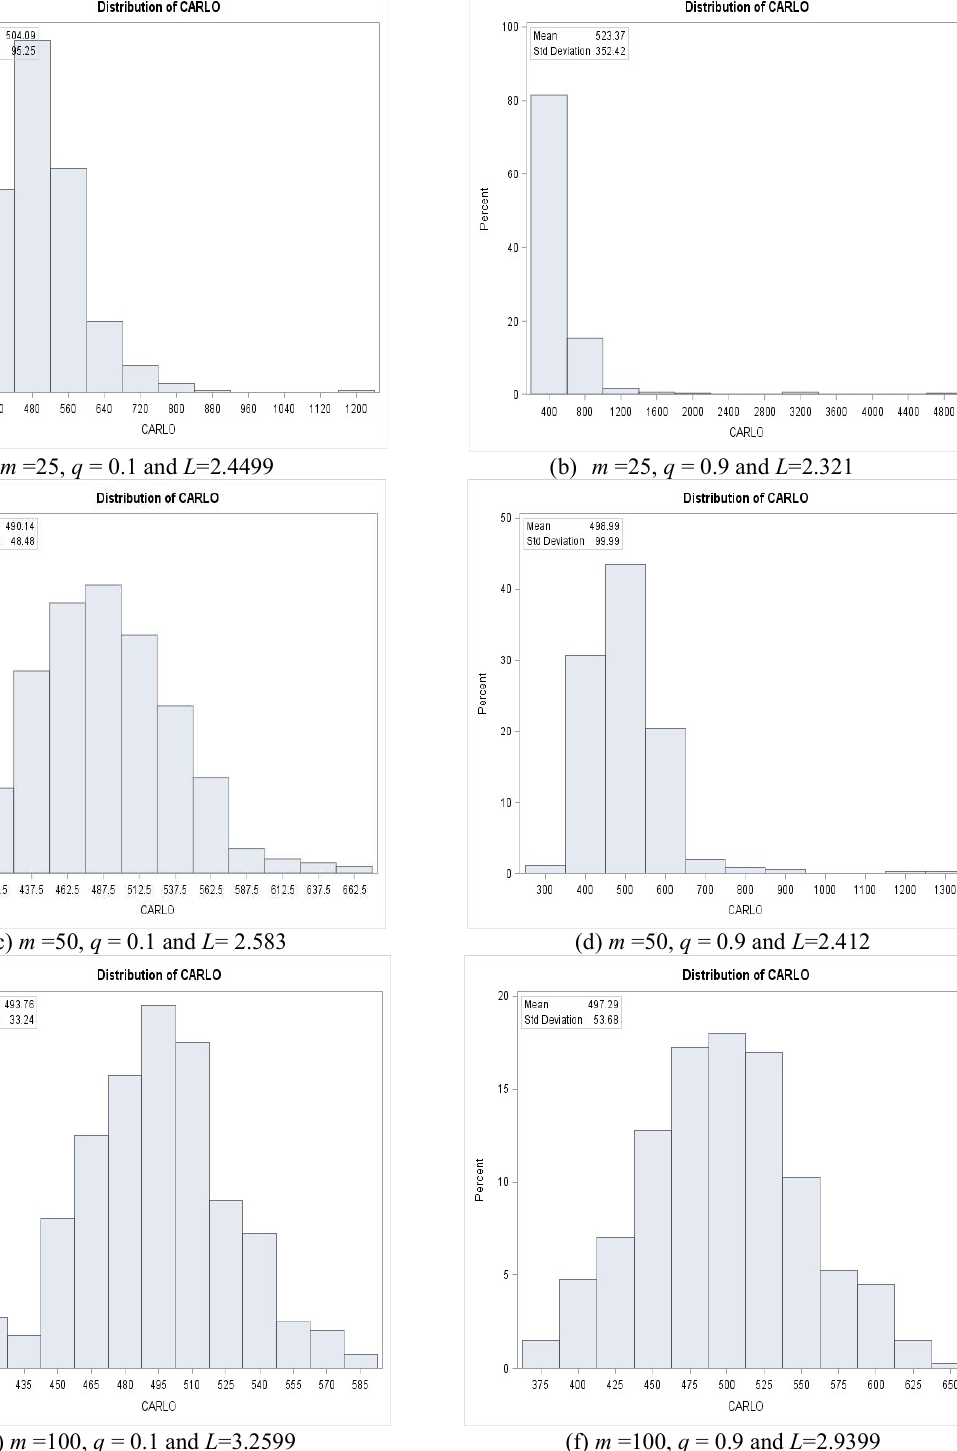
(e) m =100, q = 0.1 and L =3.2599 (f) m =100, q = 0.9 and L =2.9399 Panel 1: 𝛼 = 0.5 and 𝑞 ∈ {0.1,